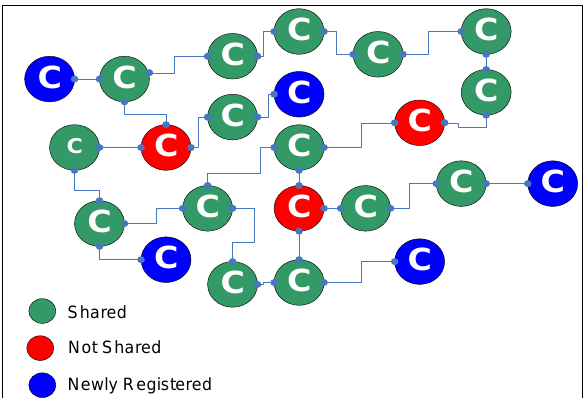
Figure 7. SDN controllers.